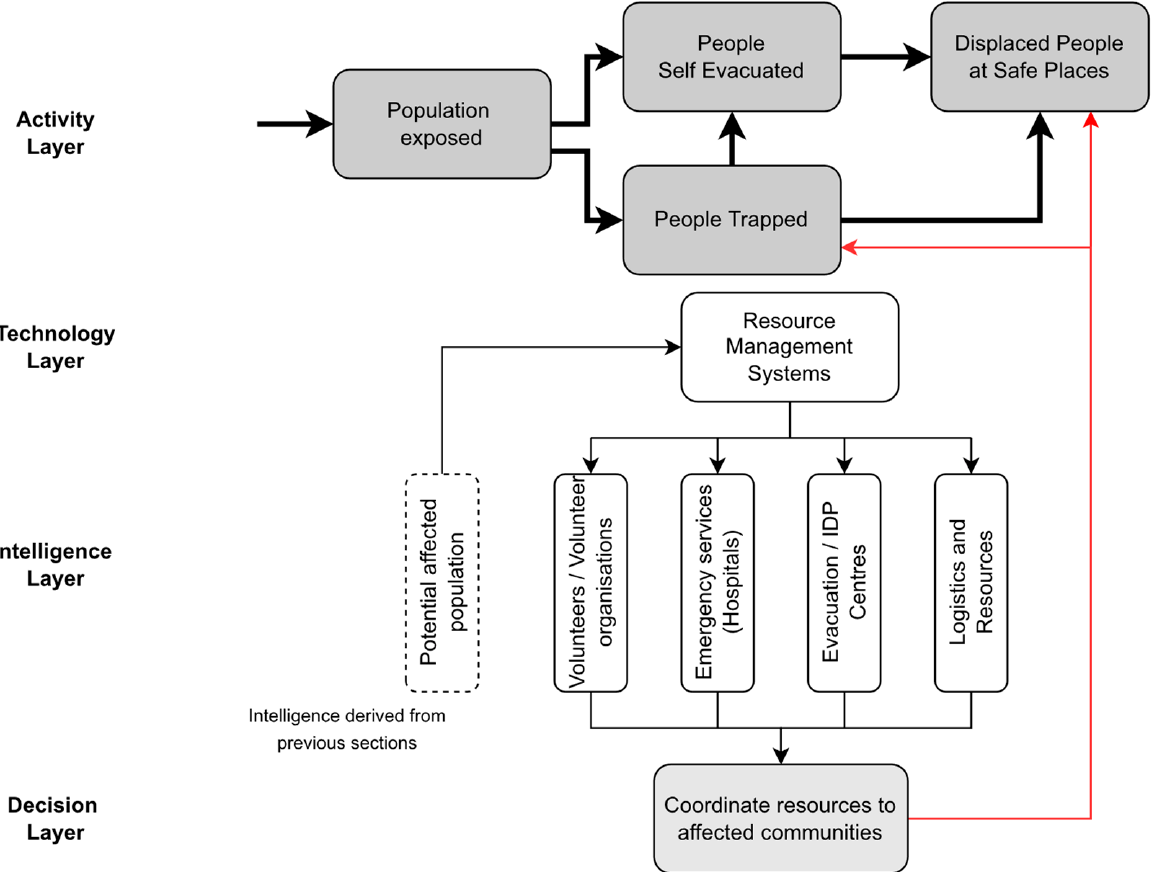
Figure 7. Intelligence required for capacities and resources in responses.